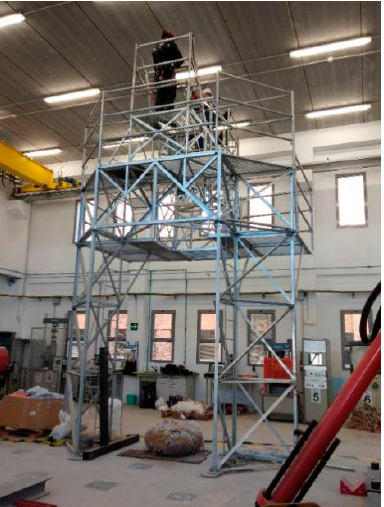
Figure 3. Steel structure for testing.